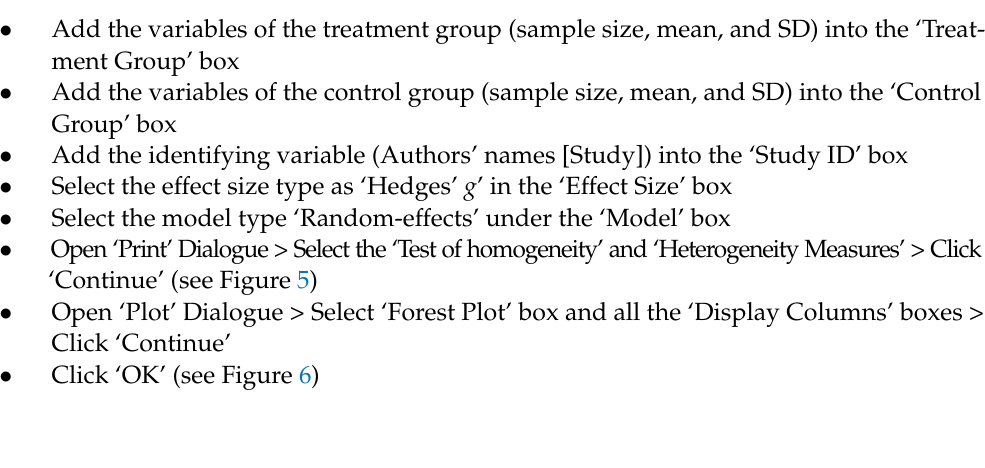
Figure 4. Meta-analysis with Raw Data.